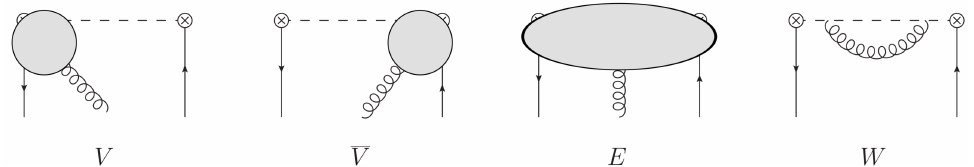
Figure 1 . Contributions of different topology to the light-ray OPE of the quark-antiquark